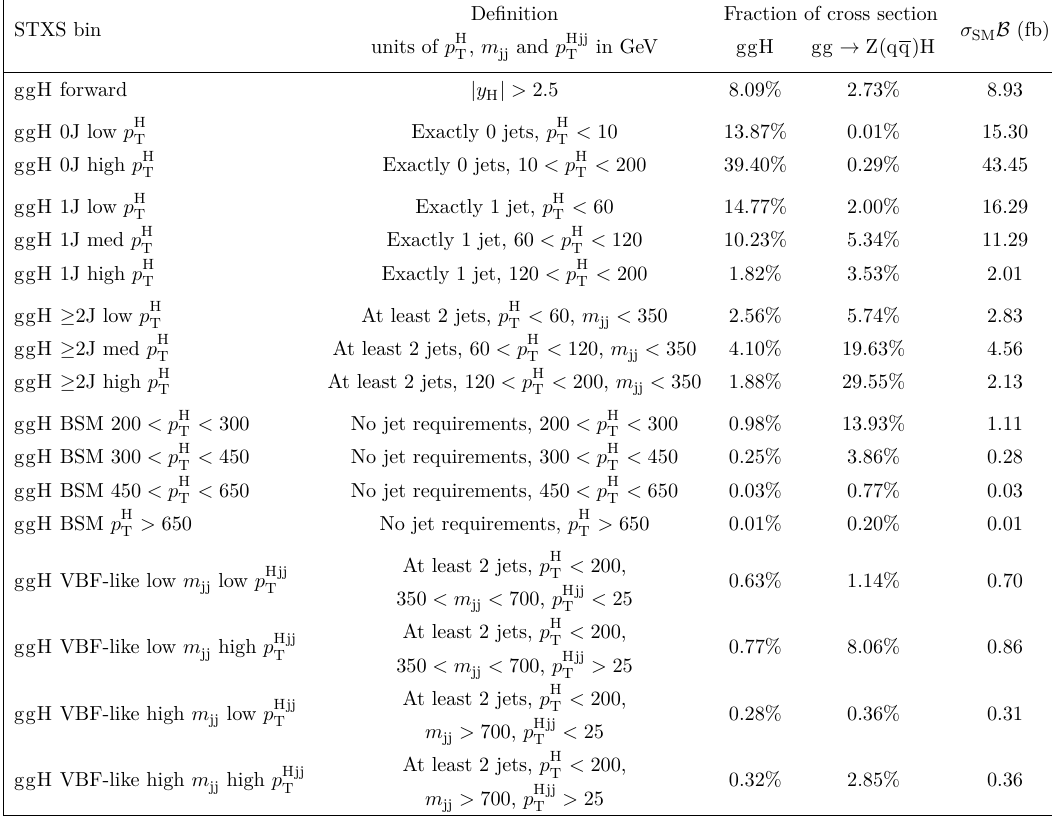
Table 2 . Definition of the ggH STXS bins. The product of the cross section and branching fraction √ ( B ), evaluated at = 125 GeV, is given for each bin in the last column. The s = 13 TeV and m H fraction of the total production mode cross section from each STXS bin is also shown. Events originating from ggZH production, in which the Z decays hadronically, are grouped together with the corresponding ggH STXS bin in the STXS measurements and are shown as a separate column in the table. The bbH production mode, whose σ B = 1 . 054 fb, is grouped together with the SM ggH 0J high p H bin. Unless stated otherwise, the STXS bins are defined for | y | < 2 . 5 . H T